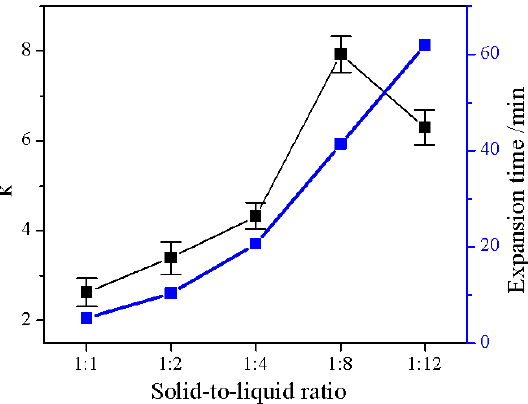
Figure 6. The effect of solid – liquid ratio on expansion rate and expansion time.